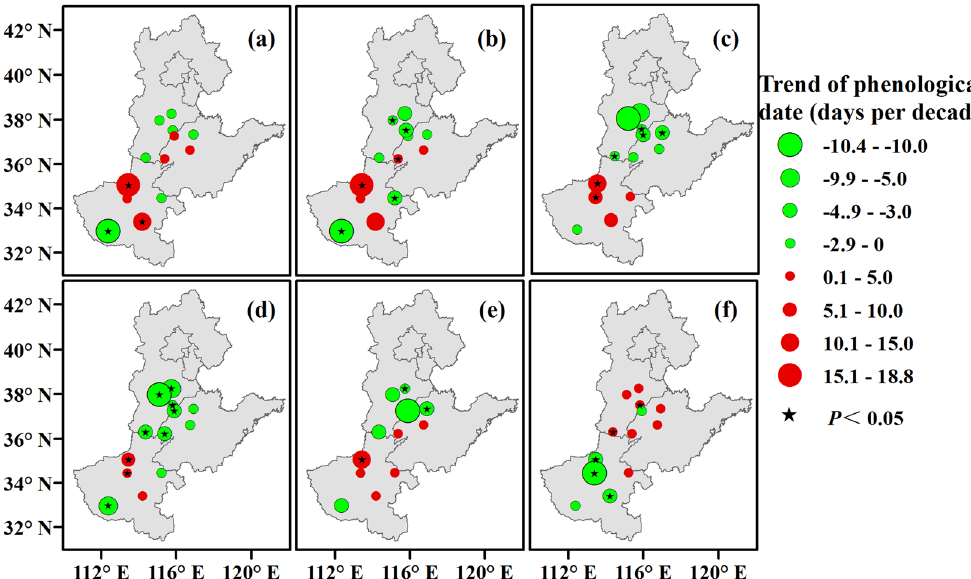
Figure 2. Spatiotemporal changes in the cotton sowing ( a ), emergence ( b ), squaring ( c ), flowering ( d ), boll opening ( e ), and harvest ( f ) dates across the North China Plain from 1981 to 2012. Green and red circles represent the trends of the phenological date. Black pentagrams represent the trends at the stations, with a significance level of 0.05. Maps were generated using ArcGIS 10.1 (ESRI Inc, Redlands, CA, USA, http://www. esri.com/).